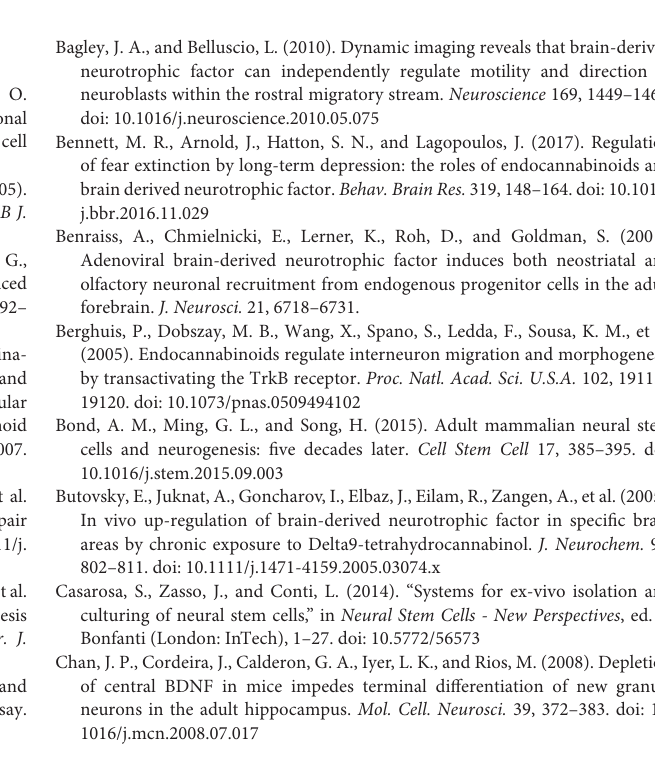
FIGURE S1 | CB2R modulation regulates DG cell-fate. Non-selective cannabinoid receptor activation or selective CB2R activation increased DG self-renewing capacity and these effects were dependent on CB2R. (A–D) Bar graphs depict the percentage of Sox2 + / + , Sox2 + / − , Sox2 − / − cell pairs expressed as percentage of total cells per culture. Data are expressed as mean ± SEM. n = 5–7. ∗ p < 0.05, ∗∗ p < 0.01 and ∗∗∗ p < 0.001 using Dunnett’s multiple comparison